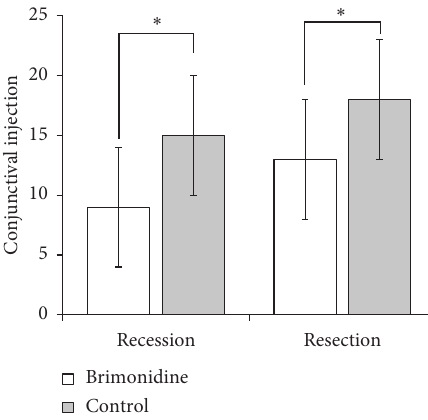
Figure 2: Comparison of conjunctival injection between the bri- monidine group and control group. The mean score of injection at the temporal bulbar conjunctiva overlaying an area of the previous lateral rectus recession was significantly lower in the brimonidine group, 9.1 ± 9.9 in the brimonidine group and 15.9 ± 9.8 in the control group ( p � 0 . 008). At the nasal bulbar conjunctiva over- laying an area of the previous medial rectus resection, the mean score of conjunctival injection was significantly lower in the bri- monidine group, 13.0 ± 11.1 in the brimonidine group and 18.6 ± 10.5 in the control group ( p � 0 .